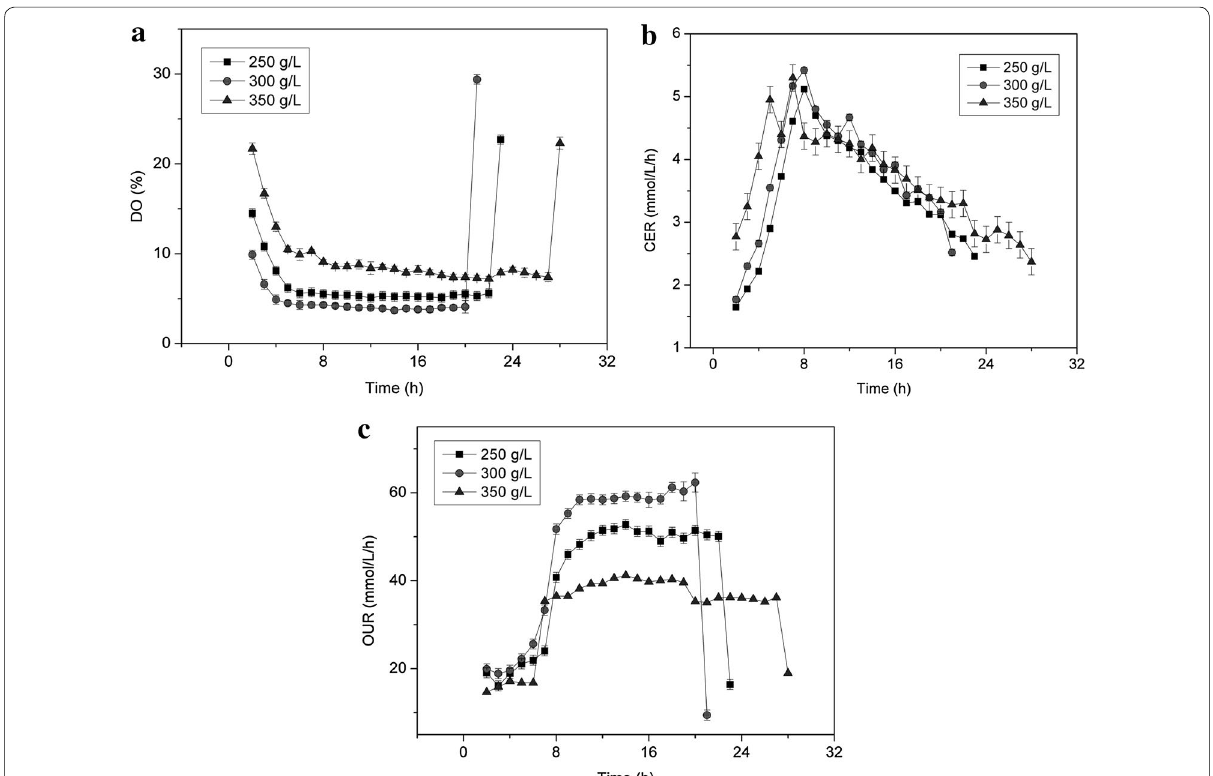
Fig. 10 Time courses of DO ( a ), CER ( b ), and OUR ( c ) in fermentation processes with different seed cultures of A.